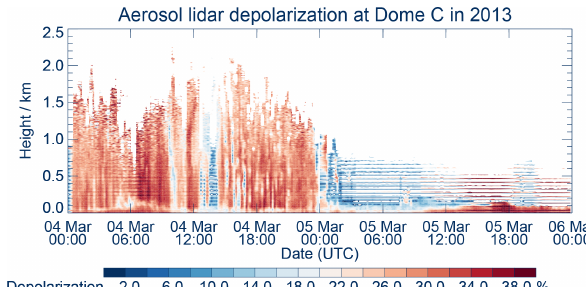
Figure 6. Time evolution of absolute humidity from 15 March to 8 April 2011 above Dome C as measured by the HAMSTRAD ra- diometer from 0 to 5km.